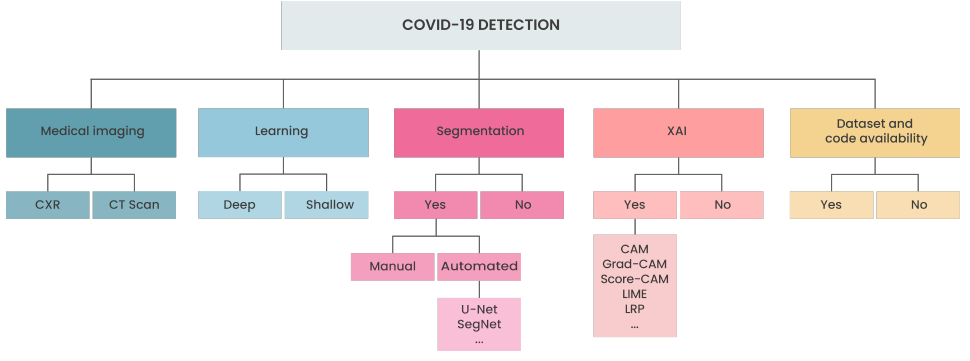
Figure 2. Taxonomy used to conduct the